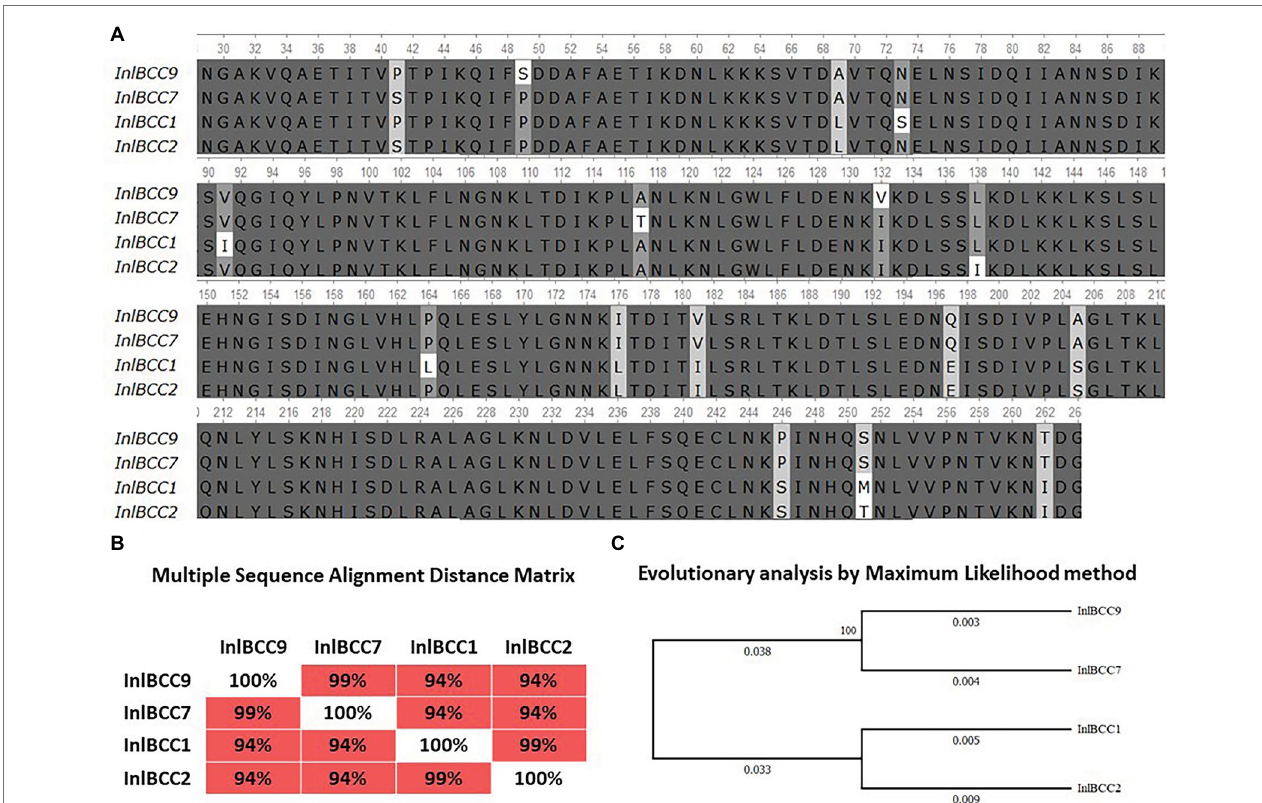
FIGURE 8 | Divergence of naturally occurring variants of the InlB internalin domain. (A) Alignment of protein sequences InlBCC1, InlBCC2, InlBCC7, and InlBCC9 (amino acids 29-262 N-cap, LRR, and Ig-like domains) by using the Clustal W program (Conway Institute UCD Dublin, Des Higgins, Dublin, Leinster, Ireland). The areas marked in orange represent amino acids under positive selection, as shown by Tsai et al. (2006). (B) To assess the matching of the distance between multiple sequence alignments, we utilized UniPro UGENE software. (C) The amino acid sequences were analyzed using the maximum likelihood method based on